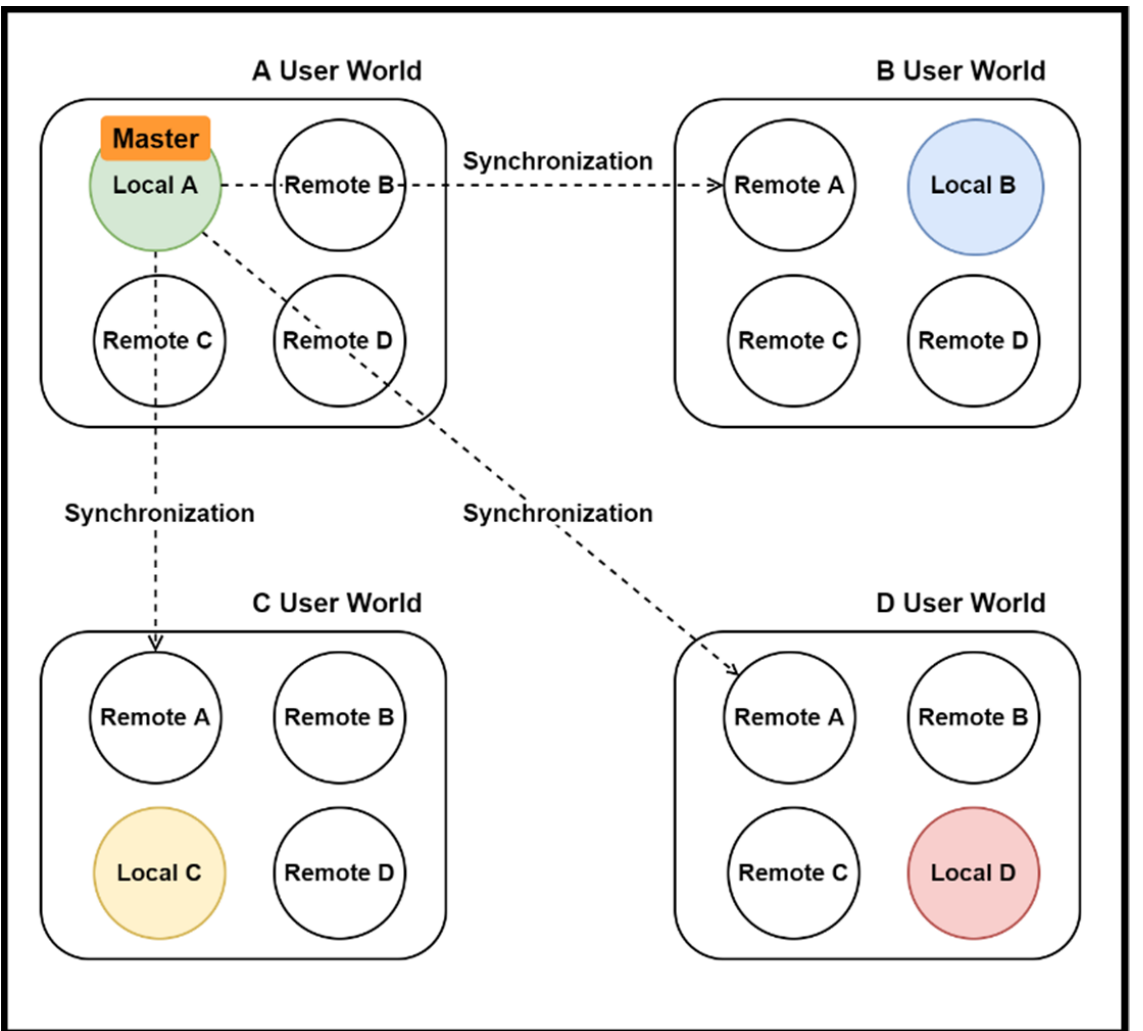
Figure 6. Photon network synchronization.